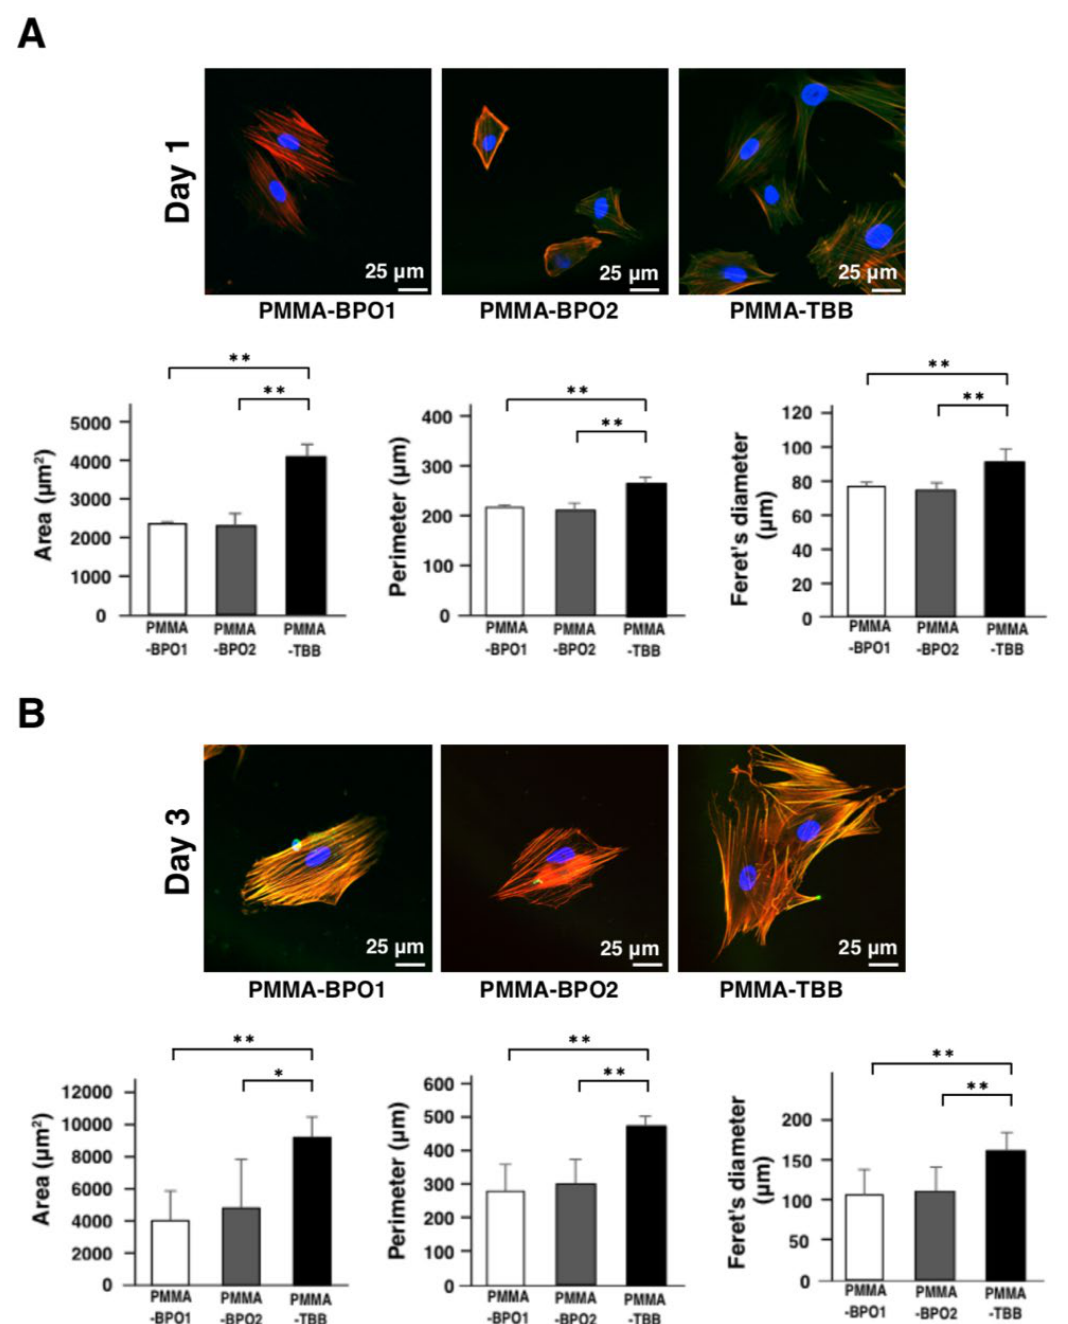
Figure 3. Spreading and cytoskeletal arrangement of osteoblasts exposed to three different bone cement extracts 1 and 3 days after seeding. Representative high magnification confocal microscopy images of the spreading behavior of osteoblasts stained with rhodamine phalloidin for actin filaments (red), DAPI for nuclei (blue), and vinculin (green) after ( A ) 1 day and ( B ) 3 days of culture (top panels). Cell morphometry analysis of the images (histograms shown below). Data shown are mean ± SD ( n = 5). Significant differences between the three groups are shown (one-way ANOVA followed by Bonferroni correction, * p < 0.05, ** p < 0.01).